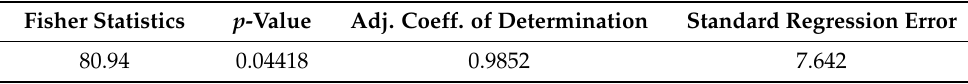
Table 11. Results of Fisher statistics.